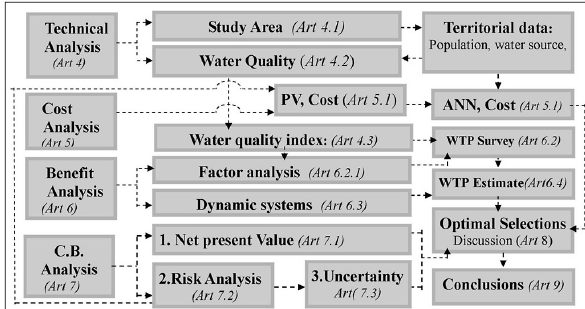
Figure 1. Block Diagram for the